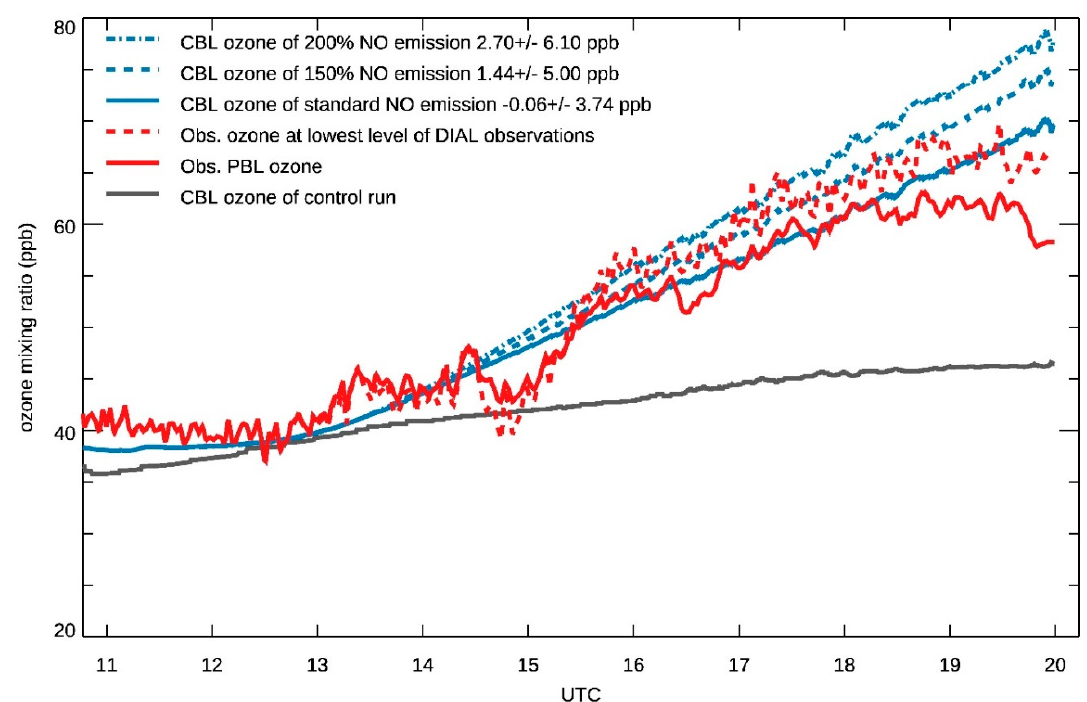
Figure 6. Observed and simulated convective boundary layer (CBL) ozone variations. The blue dashed–dotted, dashed, and solid lines are simulated CBL ozone with 100% more NO emission, 50% more NO emissions, and standard NO emissions, respectively, followed by the mean difference (observed CBL ozone minus corresponding simulated CBL ozone values) and standard deviations. Simulated CBL ozone values were averaged over the whole domain. The red dashed and solid lines represent, respectively, the ozone mixing ratio, the lowest level of ozone DIAL observations, and the CBL ozone observed by ozone DIAL. The solid gray line represents the CBL ozone simulated by the control run.